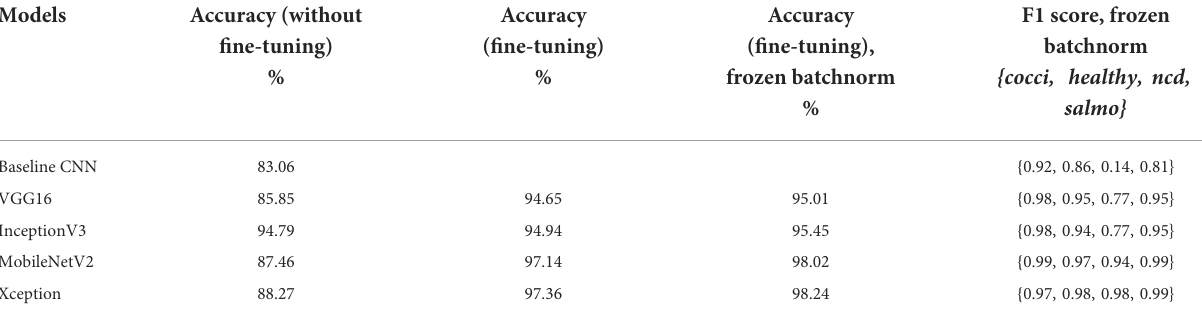
TABLE 2 Model performance results—accuracy and F1 scores (from frozen